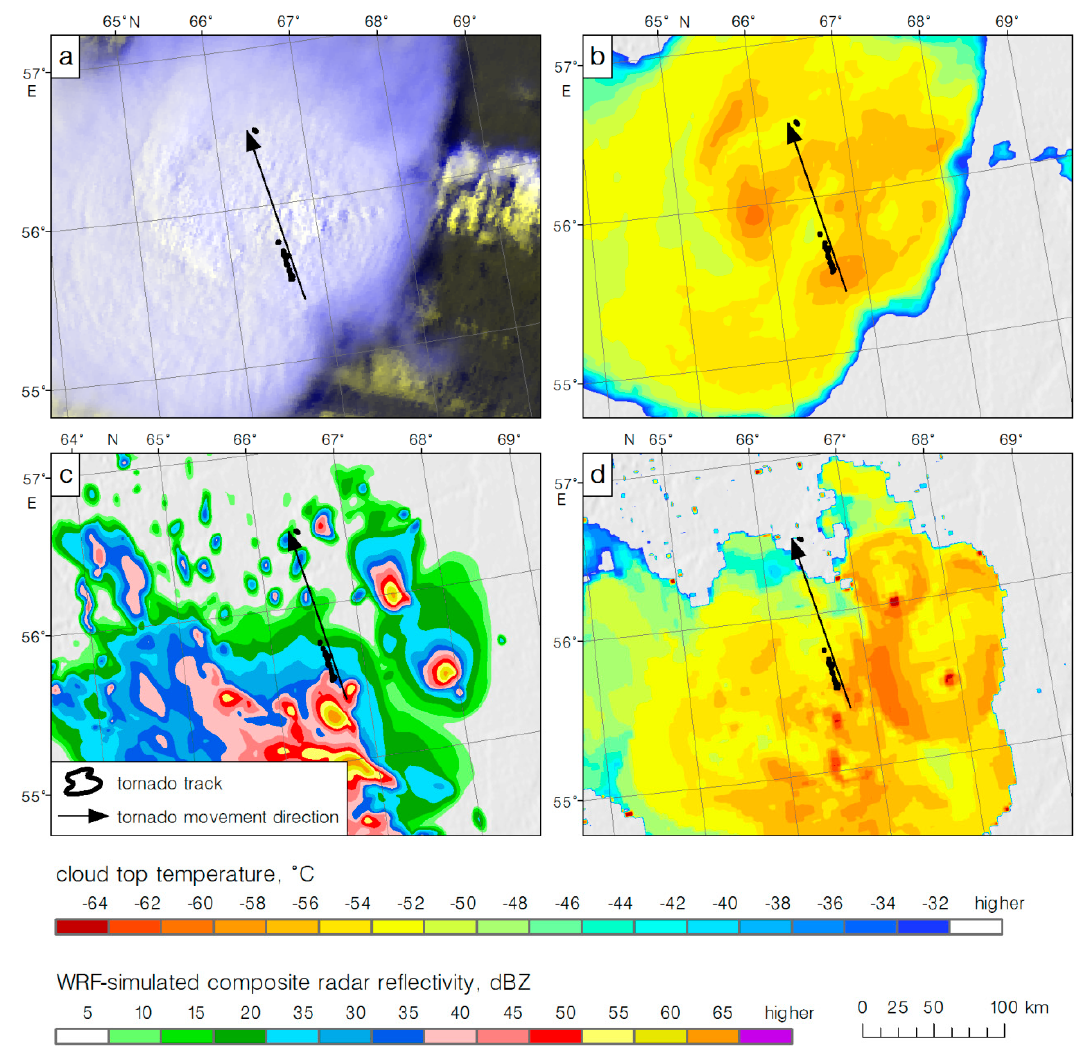
Figure 12. HRV cloud RGB image ( a ) and cloud top temperature ( b ) by the Meteosat-8 data; WRF-simulated composite reflectivity ( c ) and cloud top temperature ( d ) at 1200 UTC 18 June 2017 (the WRF configuration with a 3-km resolution with no nested grid).